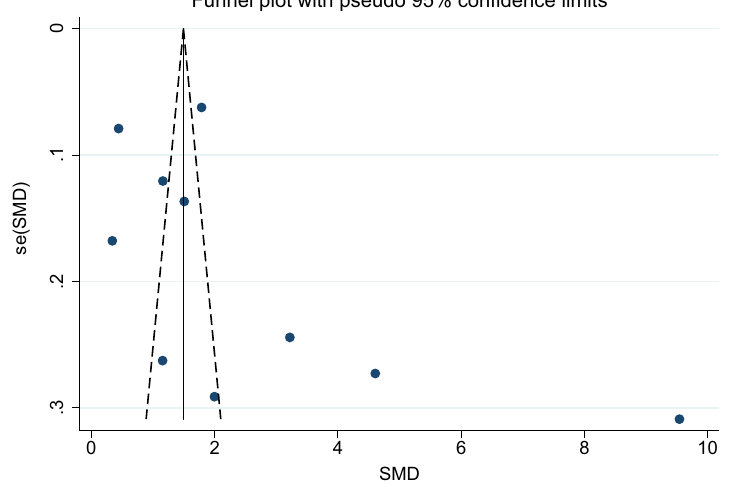
Figure 15. Funnel plot demonstrates the publication bias among 11 studies comparing the mean CRP level between patients with asymptomatic malaria and healthy/febrile controls. SMD, standard mean difference; se, standard